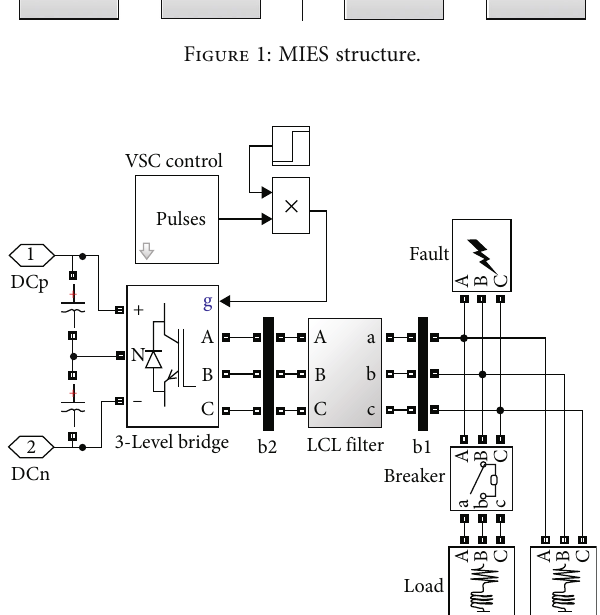
Figure 1: MIES structure.